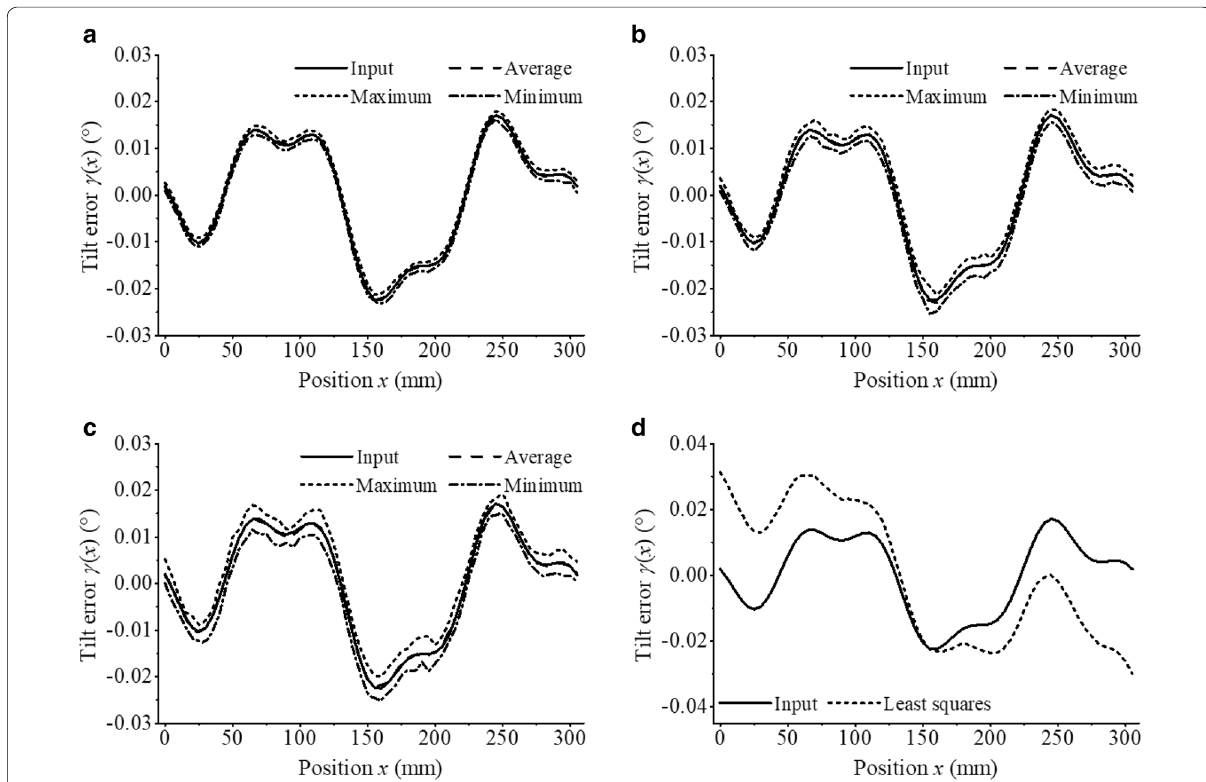
Figure 4 Simulation results connected with γ ( x ): average curve, maximum curve, minimum curve and input curve as a σ σ 0.3 μm, d least squares curve and input curve as σ =